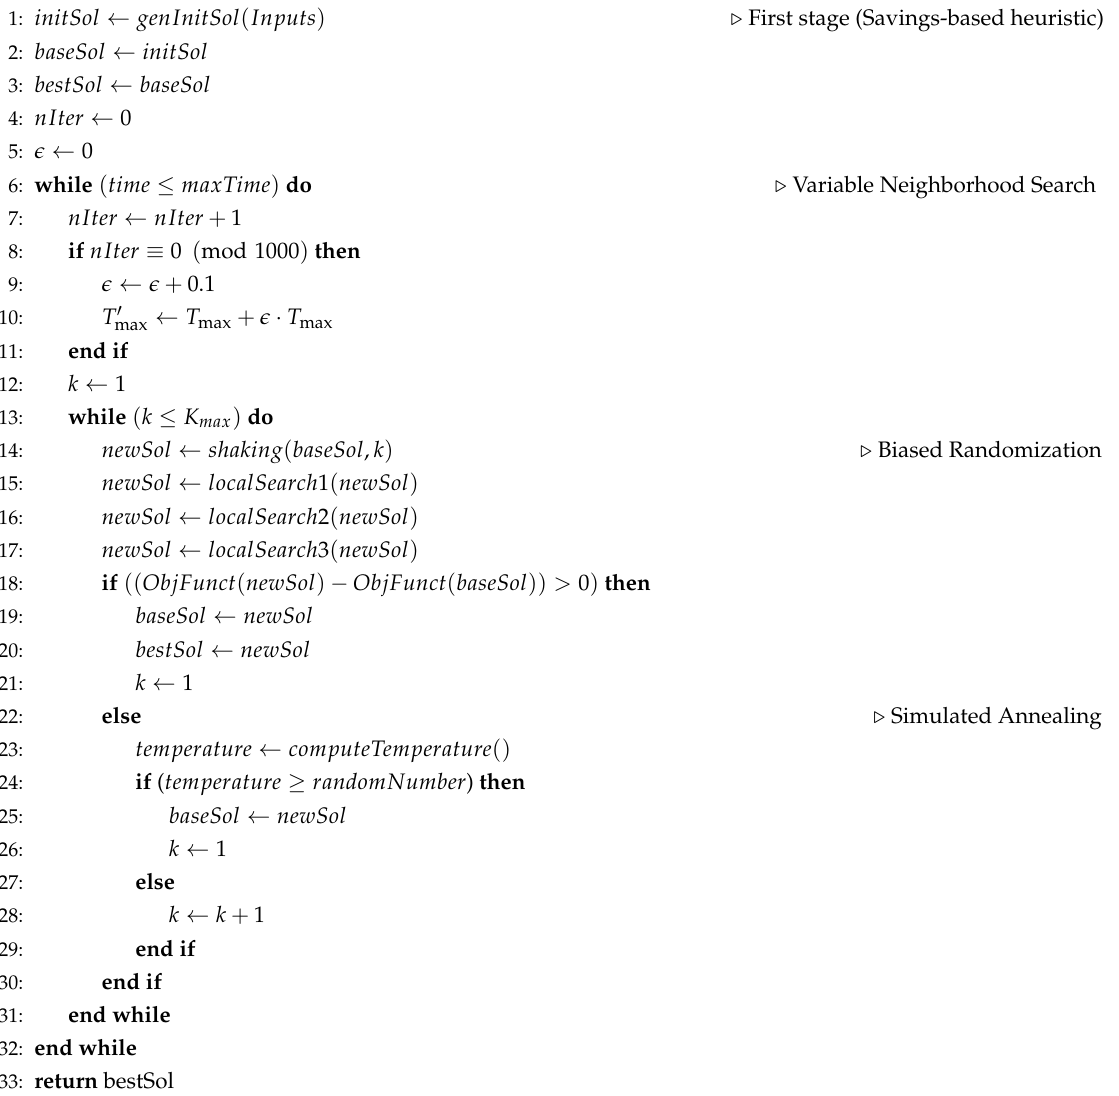
Algorithm 1 Biased-randomized variable neighborhood search (BR-VNS)